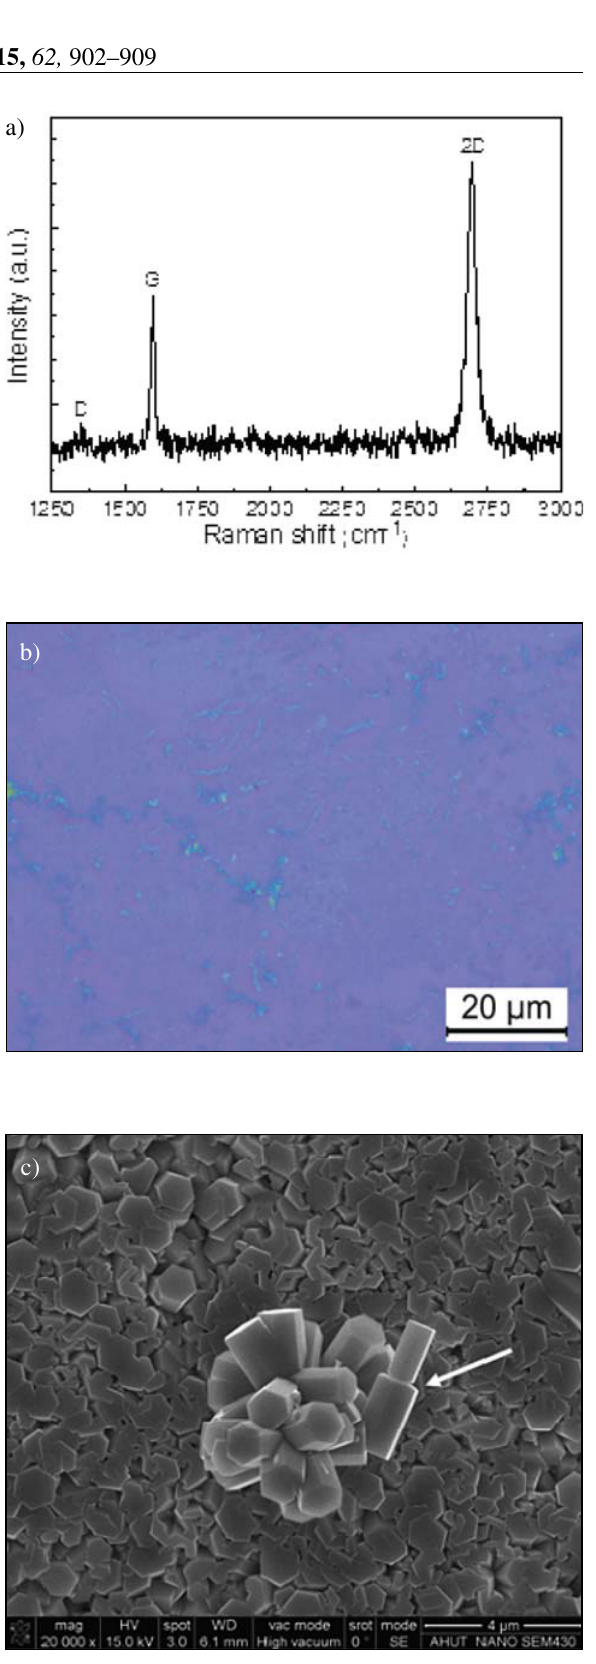
Fig. 3. (a) Raman spectrum of monolayer graphene, (b) OM image of monolayer graphene on SiO ZnO microrods grown on monolayer graphene by the hydrothermal